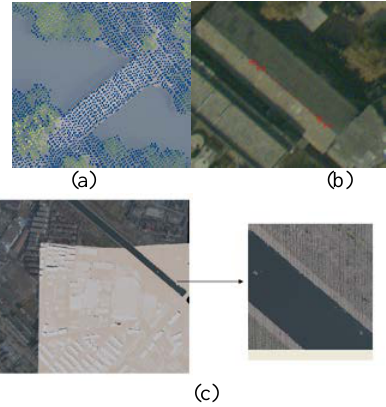
Fig.7 Registration result of multi- images and LiDAR points